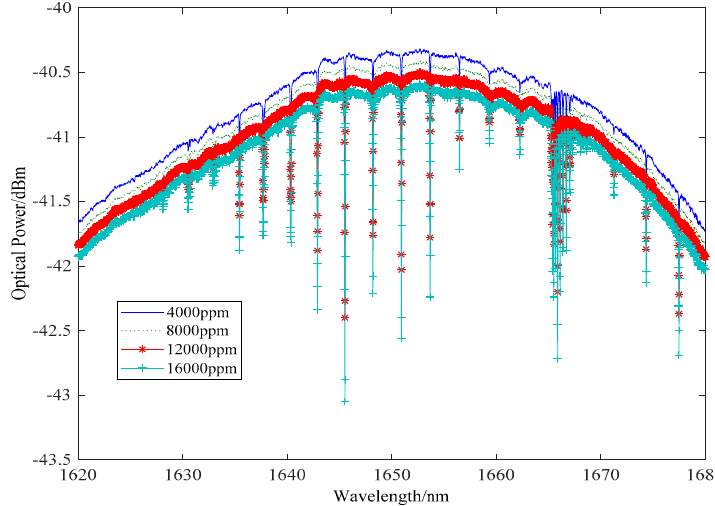
Figure 4. Spectra of four concentrations of methane gas.